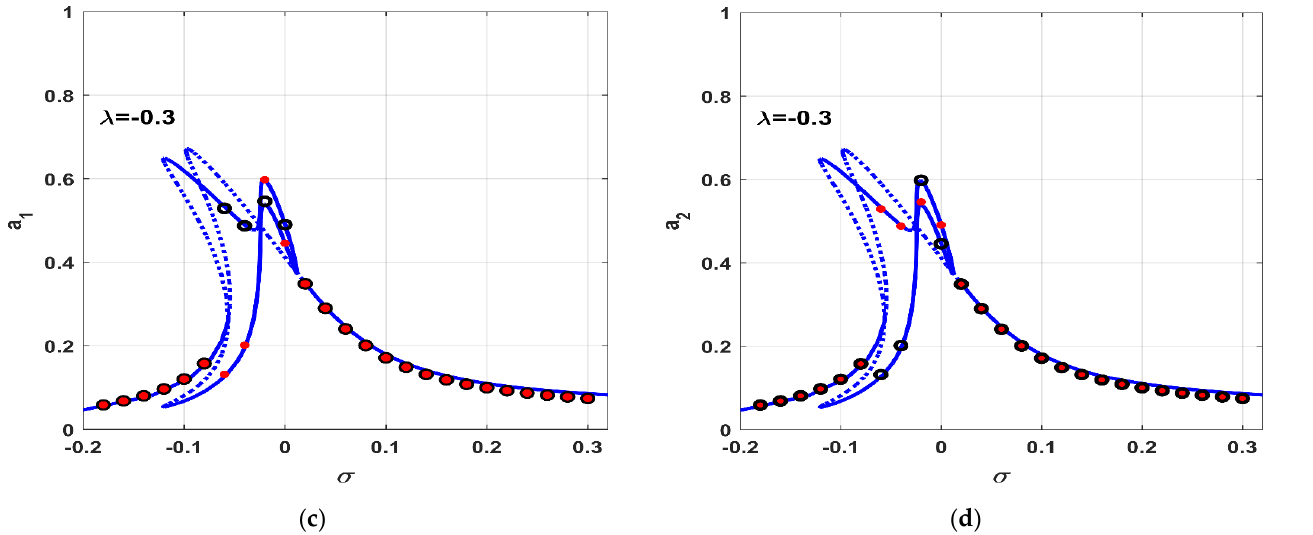
Figure 12. 𝜎 − response curve of the controlled Jeffcott rotor (i.e., 𝐸 = 0.03, 𝛿 (cid:2869) = 0.83 , and 𝛿 (cid:2870) = Figure 12. σ —response curve of the controlled Jeffcott rotor (i.e., E = 0.03, δ 1 = 0.83, and δ 2 = 0.002) 0.002 ) at the negative and positive non-linear stiffness coefficient ( 𝜆 ): ( a , b ) oscillation amplitudes at the negative and positive non-linear stiffness coefficient ( λ ): ( a , b ) oscillation amplitudes ( a 1 and a 2 ) ( 𝑎 (cid:2869) and 𝑎 (cid:2870) ) versus 𝜎 when 𝜆 = 0.3 , and ( c , d ) oscillation amplitudes ( 𝑎 (cid:2869) and 𝑎 (cid:2870) ) versus 𝜎 when versus σ when λ = 0.3, and ( c , d ) oscillation amplitudes ( a 1 and a 2 ) versus σ when λ = − 0.3. 𝜆 = −0.3 .